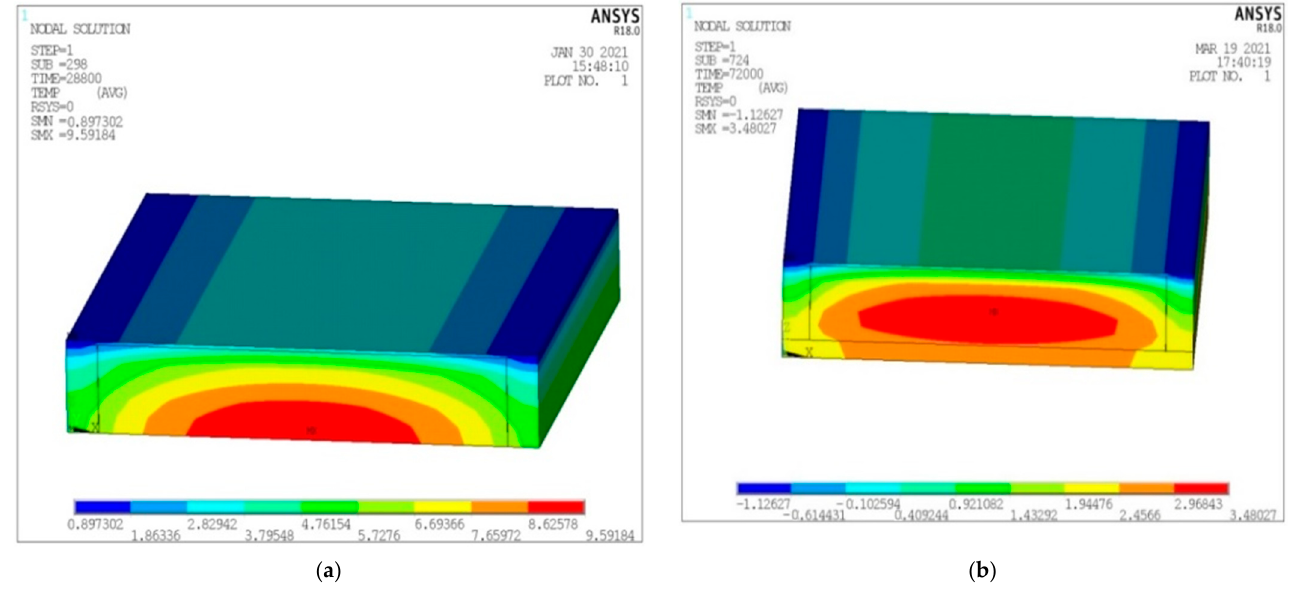
Figure 13. Cloud map of temperature field distribution in melting ice model. ( a ) Temperature field distribution nephogram with insulation layer; ( b ) Temperature field distribution cloud chart without insulation layer